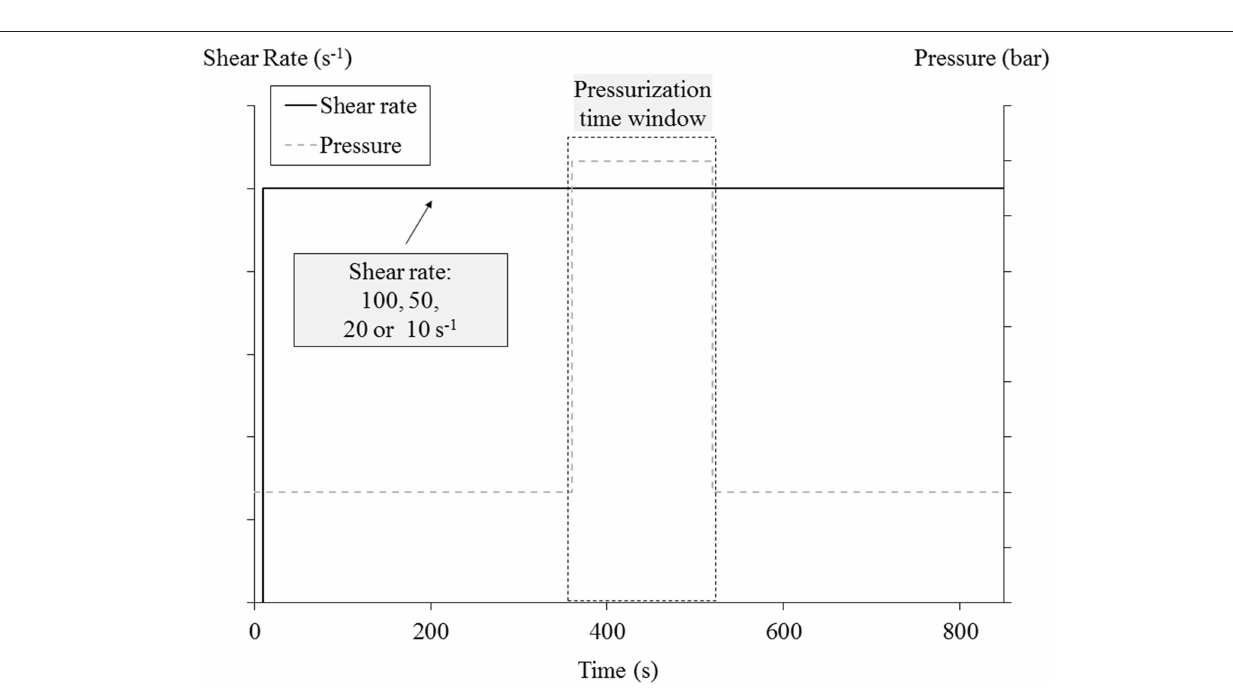
Frontiers in Materials |